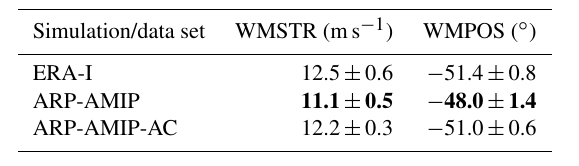
Table 3. Mean annual 850hPa westerly maximum strength (WM- STR) and position (WMPOS) in ERA-Interim, ARP-AMIP and ARP-AMIP-AC ± 1 standard deviation of the annual mean. Differ- ences significant at p = 0 . 05 with respect to ERA-I are presented in bold.